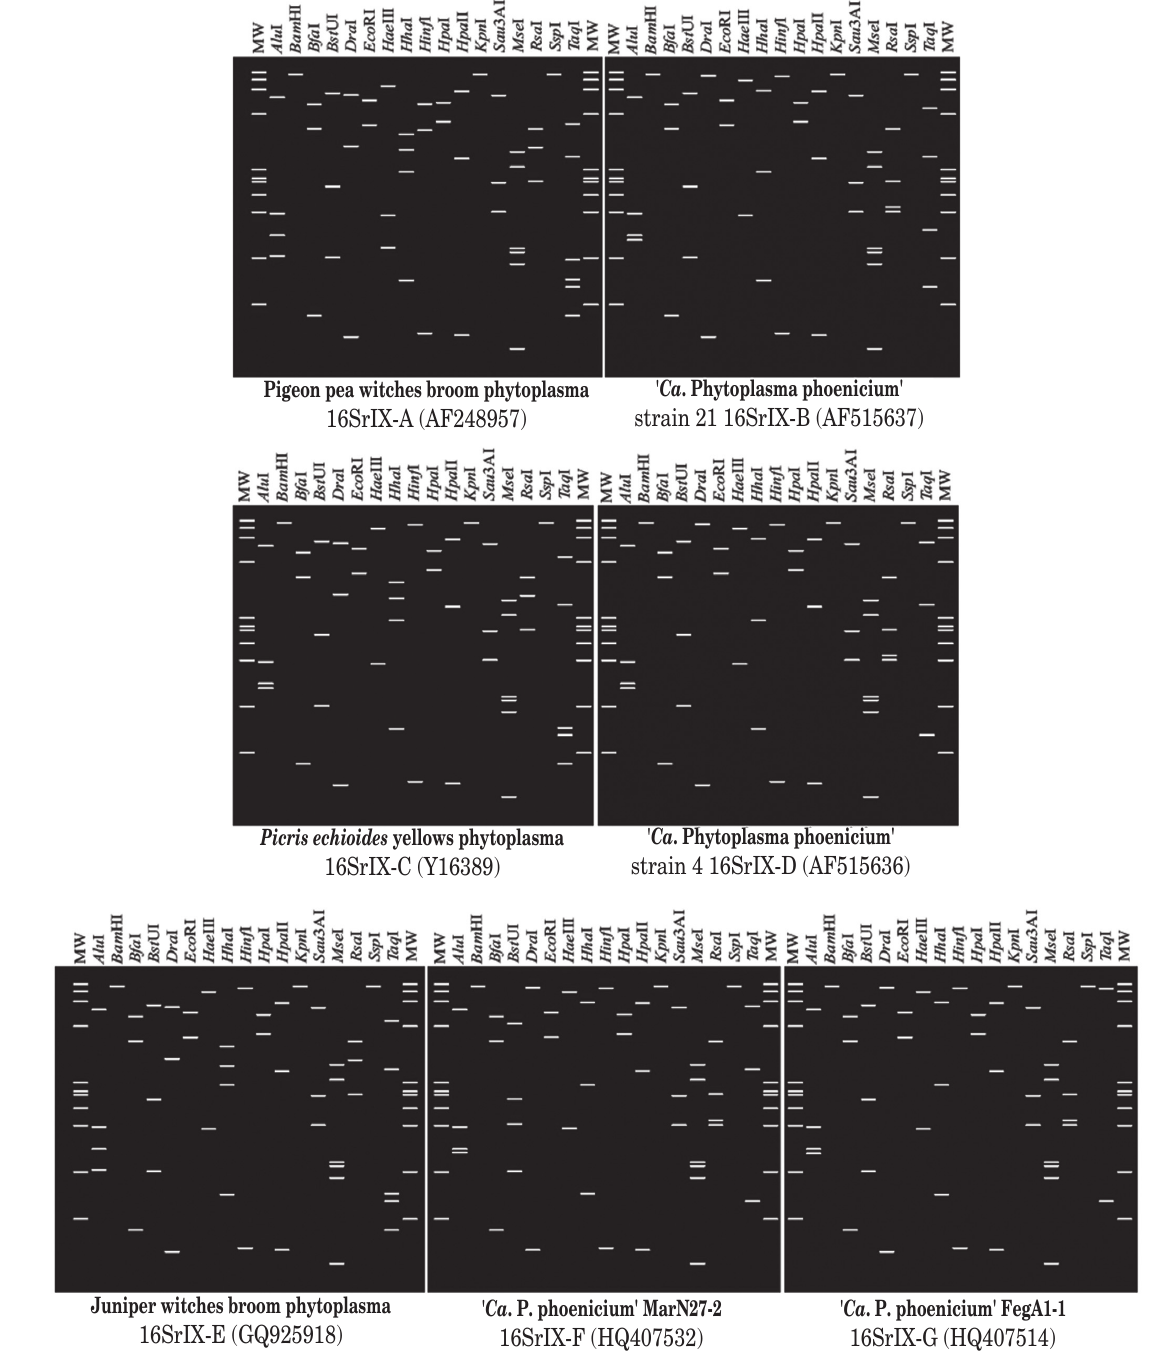
Figure 1. Virtual R16F2nR2 RFLP patterns of representative strains of 16SrIX subgroups. Recognition sites for the following 17 restriction enzymes were used in the simulated digestions: Alu I, Bam HI, Bfa I, Tha I ( Bst UI), Dra I, EcoR I, Hae III, Hha I, Hinf I, Hpa I, Hpa II, Kpn I, Sau 3AI ( Mbo I), Mse I, Rsa I, Ssp I, and Taq I. MW, FX174DNA digested by Hae III, fragment size (bp) from top to bottom: 1353, 1078, 872, 603, 310, 281, 271, 234, 194, 118,